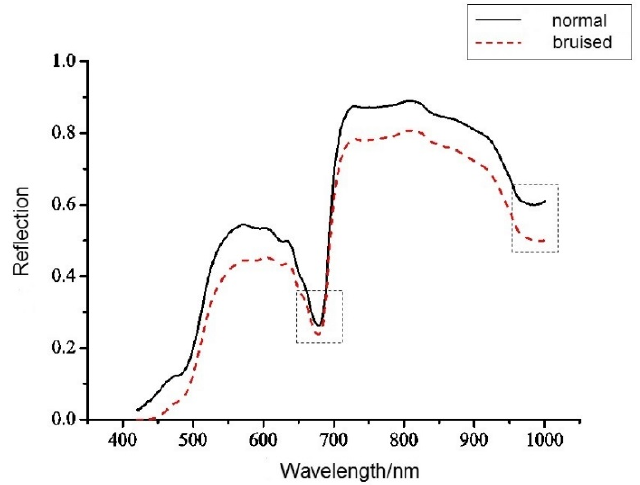
Figure 3. Averaged spectra between 420 and 1000 nm of bruised and normal pears of all samples. Two absorption peaks in the black frame represent the absorption of chlorophyll (680 nm) and water (960 nm),